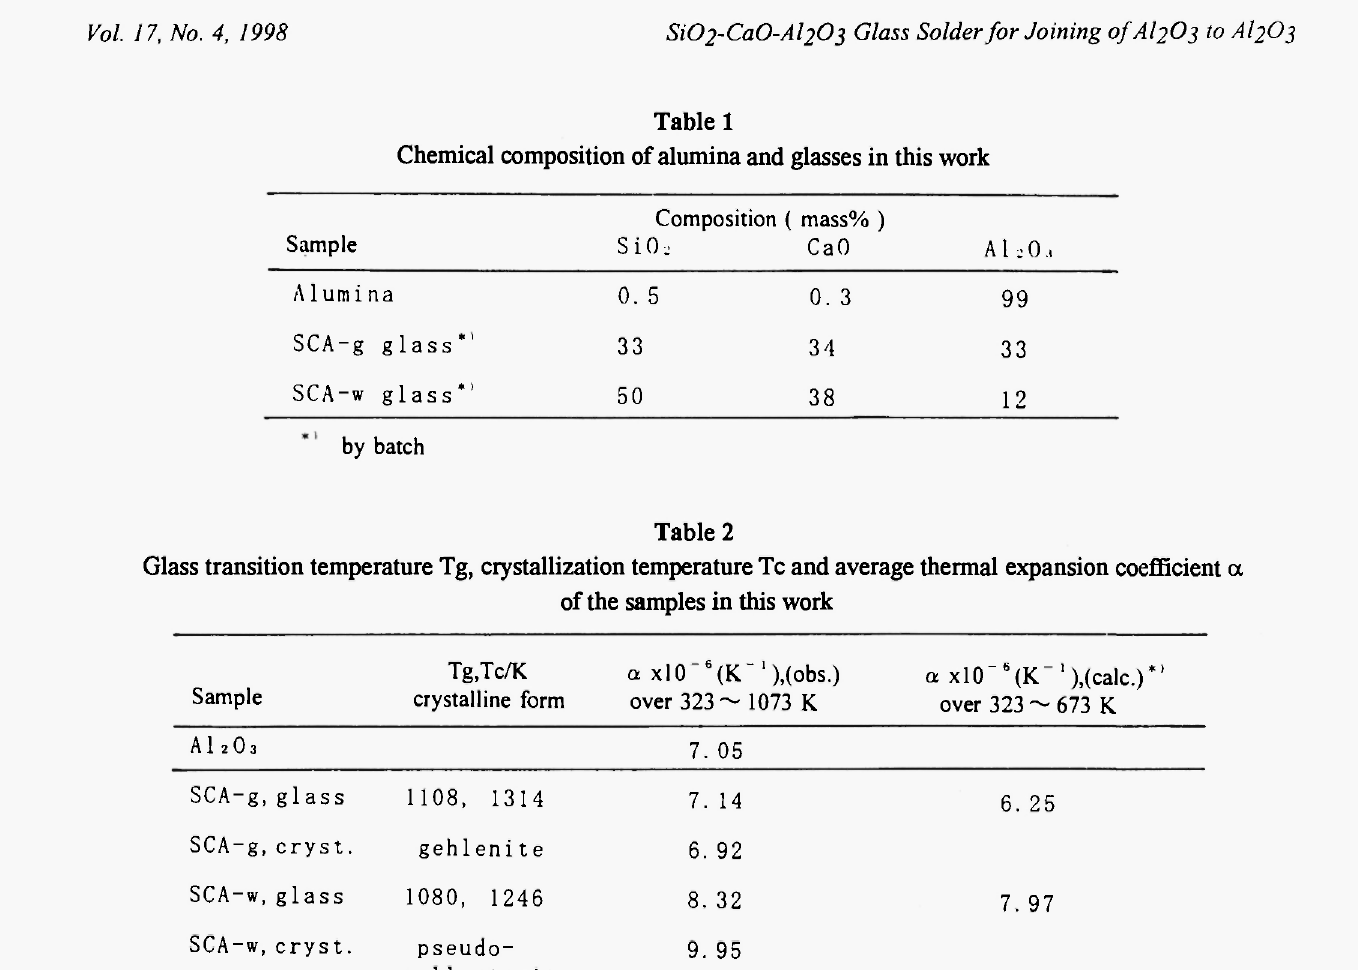
Glass transition temperature Tg, crystallization temperature Tc and average thermal expansion coefficient α of the samples in this